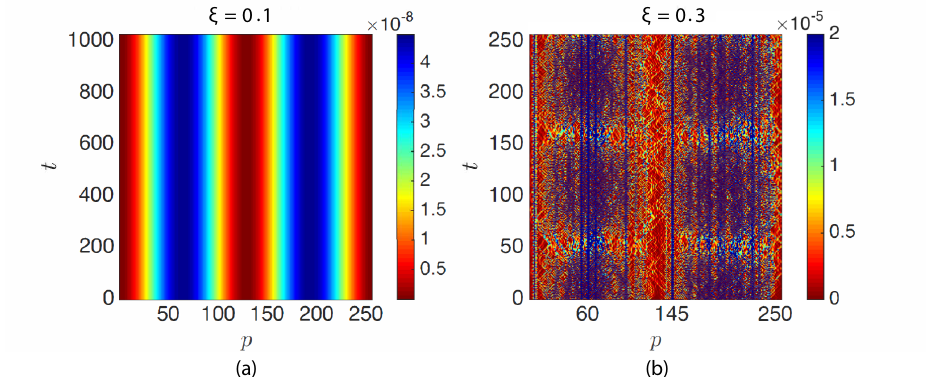
Figure 10. Total energy per particle TE ( p ) ( t ) ( p = 1 to 256) of ( a ) an ordered granular chain ( ξ = 0.0) and ( b ) a disordered granular chain ( ξ = 0.3), from the same data as in Figure 9.